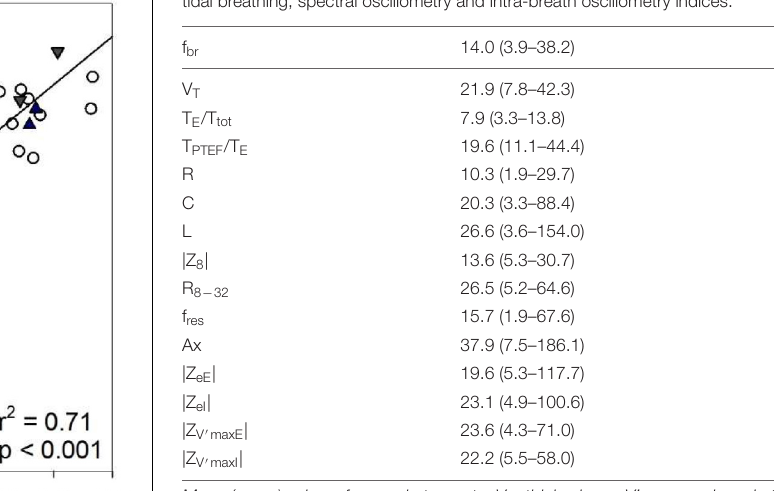
TABLE 4 | Within-session variability presented as coefficient of variation (in%) of tidal breathing, spectral oscillometry and intra-breath oscillometry